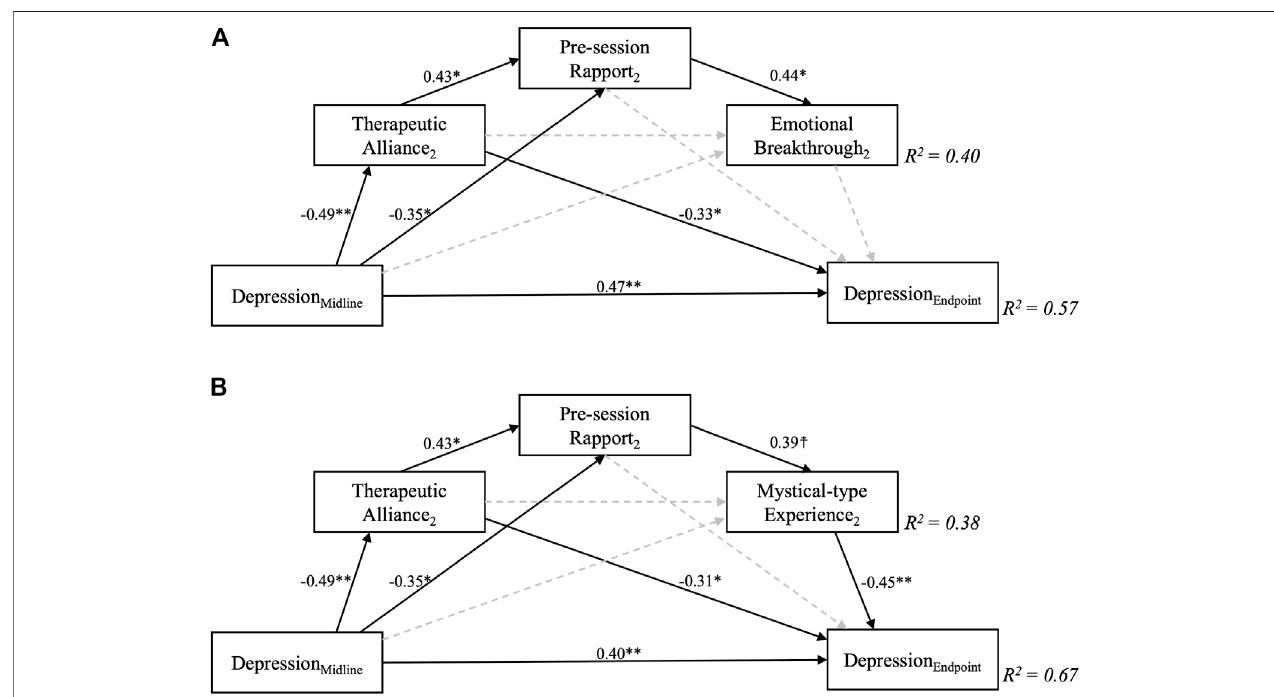
FIGURE 5 | Fully saturated sequential mediation models exploring the relationship between therapeutic alliance during the second psilocybin session and depression scores 6 weeks following a two-dose course of psychedelic-assisted psychotherapy. Sequential mediation of therapeutic alliance via pre-session rapport andB)Mystical-typeExperiences,butnotA)EmotionalBreakthroughwassupportedbythemodelsforthissecondsession.Importantly,depressionseverityat6 weeks was controlled for midline (3 weeks post- fi rst dose) depression scores, which by itself accounted for R 2 = 0.55, i.e., 55% of variance in the fi nal outcome. Greater midline depression severity signi fi cantly predicted worse therapeutic alliance and pre-session rapport scores. Decimal values represent standardised regression coef fi cients ( β values) for signi fi cant(solid, p > 0.1) but not non-signi fi cant (dashed) paths. The subscript number two refers to the second psilocybin session. ☨ indicates p < 0.1, * p < 0.05, ** p < 0.01, *** p <